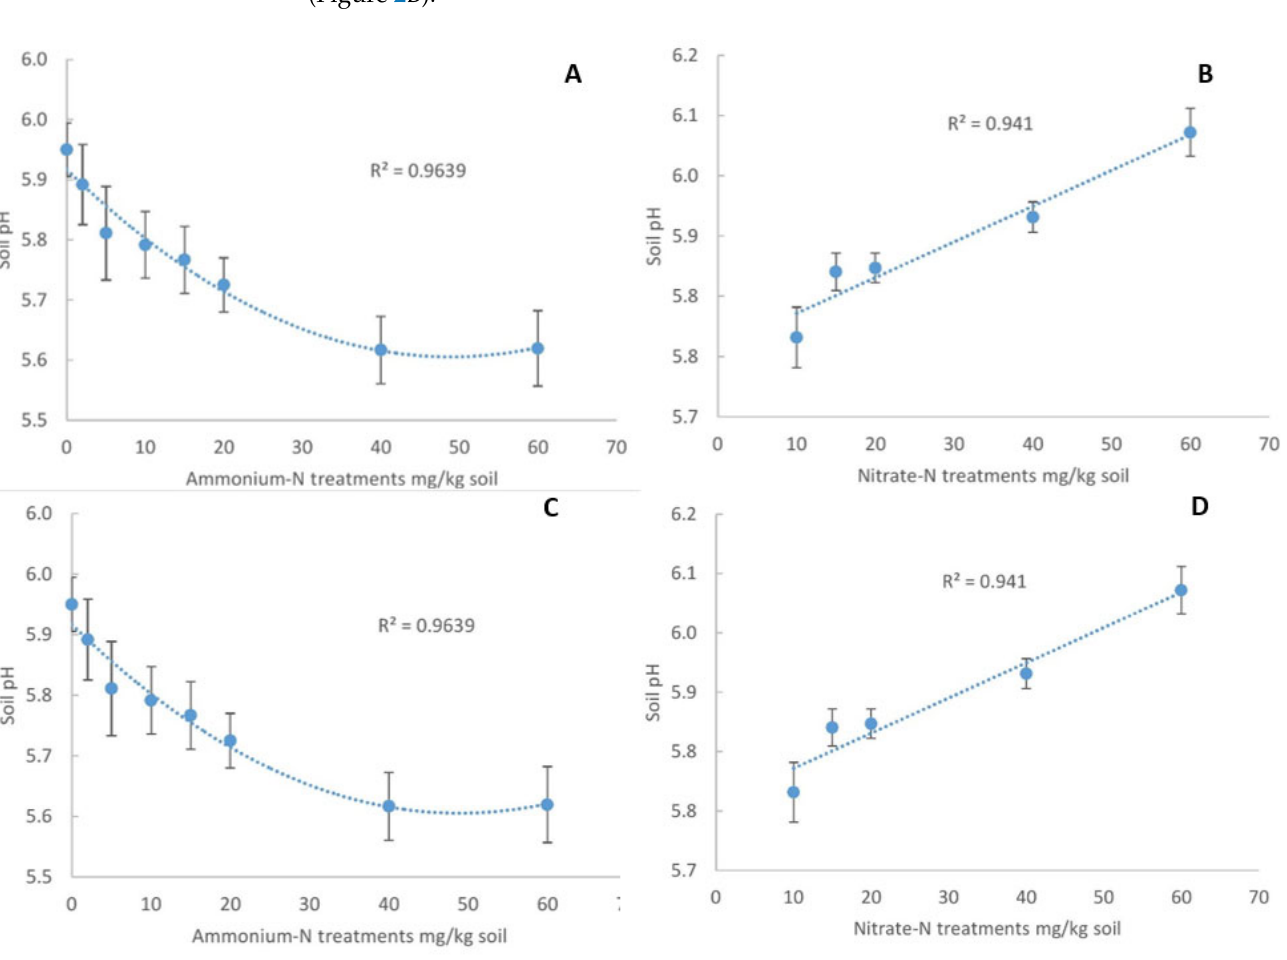
Figure 2. Effects of the ammonium (NH 4+ -N) and nitrate (NO 3 − -N) treatments on soil pH ( A , B ) and of ammonium (NH 4+ -N) ( C , D ) and nitrate (NO 3 − -N) treatments on residual NH 4+ -N in soil after 35 days. Data for each treatment are presented as mean ±SE (n =